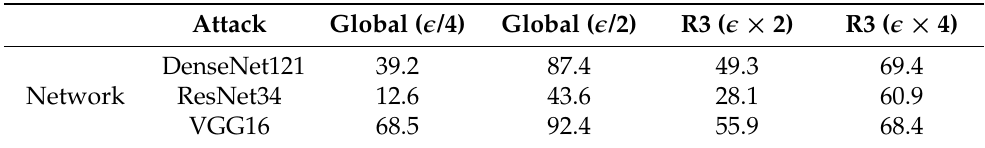
Table 6. ASR of AEs with variable perturbation scale (%).